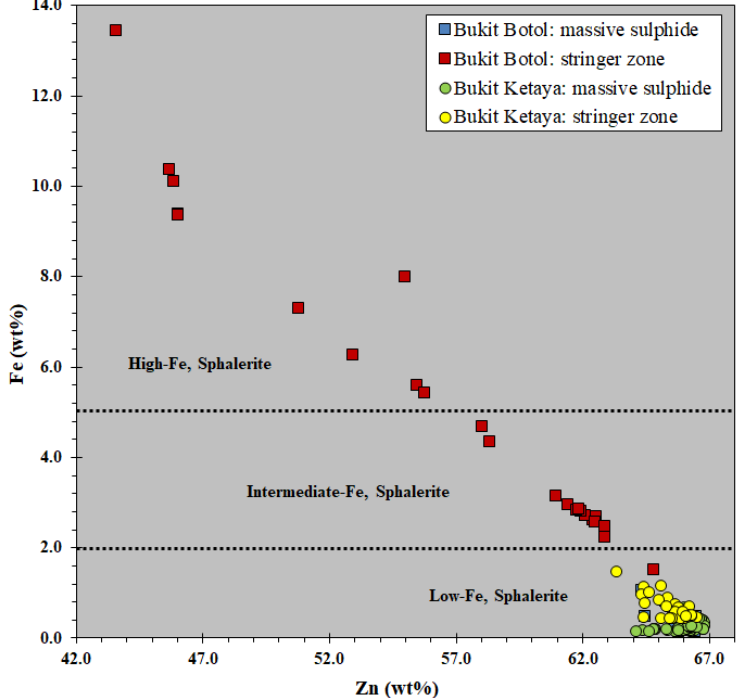
Figure 4. Binary plot of varying Fe and Zn compositions in sphalerite from the Bukit Botol and Bukit Ketaya deposits, Central Peninsular Malaysia.